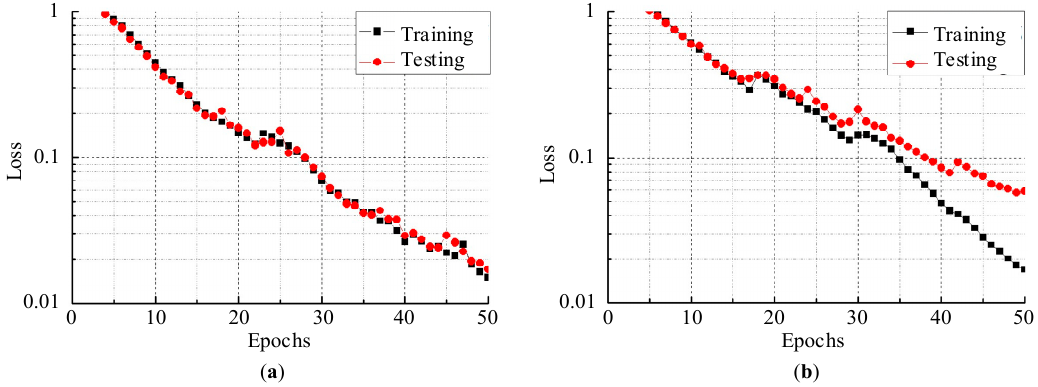
Figure 8. The cross-entropy loss function on the training set and testing set: ( a ) C_Easy1_015; ( b ) C_Difficult1_015.